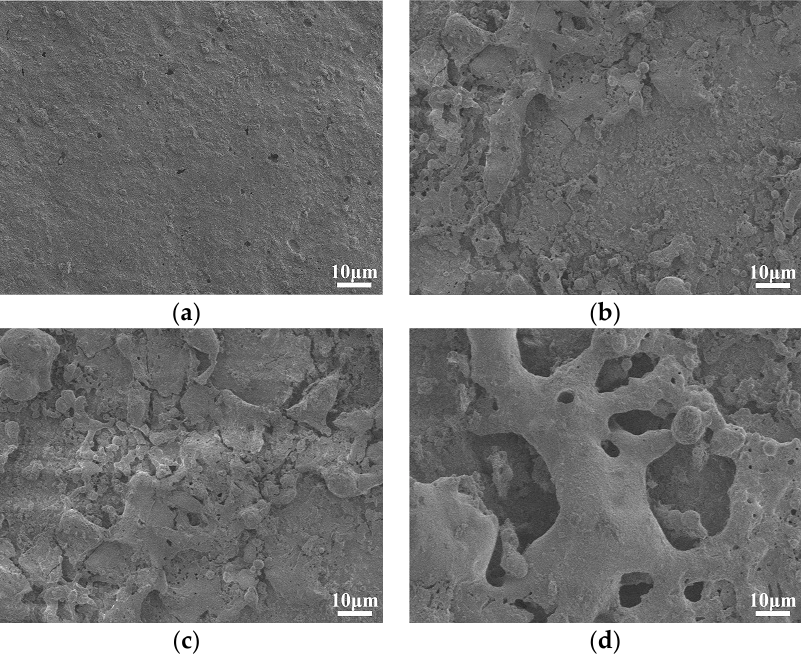
Figure 10. SEM images at different applied voltage ( γ 20 = 1000 μ S/cm, t = 8 h, 1000×). ( a ) DC 0 kV, ( b ) DC 1.6 kV, ( c ) DC 3.2 kV, ( d ) DC 3.6 kV.